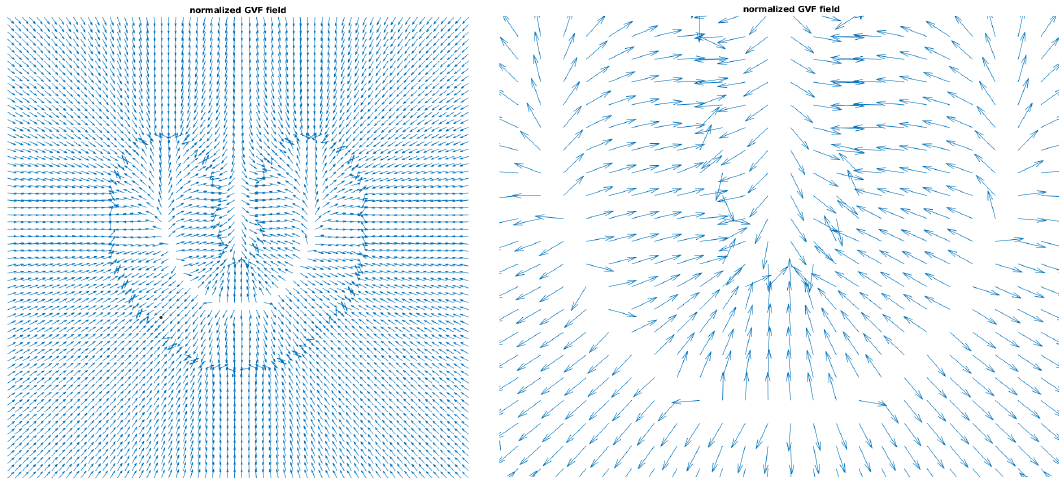
Figure 7. Example of normalized Gradient Vector Flow. ( Left ) GVF vector field for the same image used before. ( Right ) Zoom in the